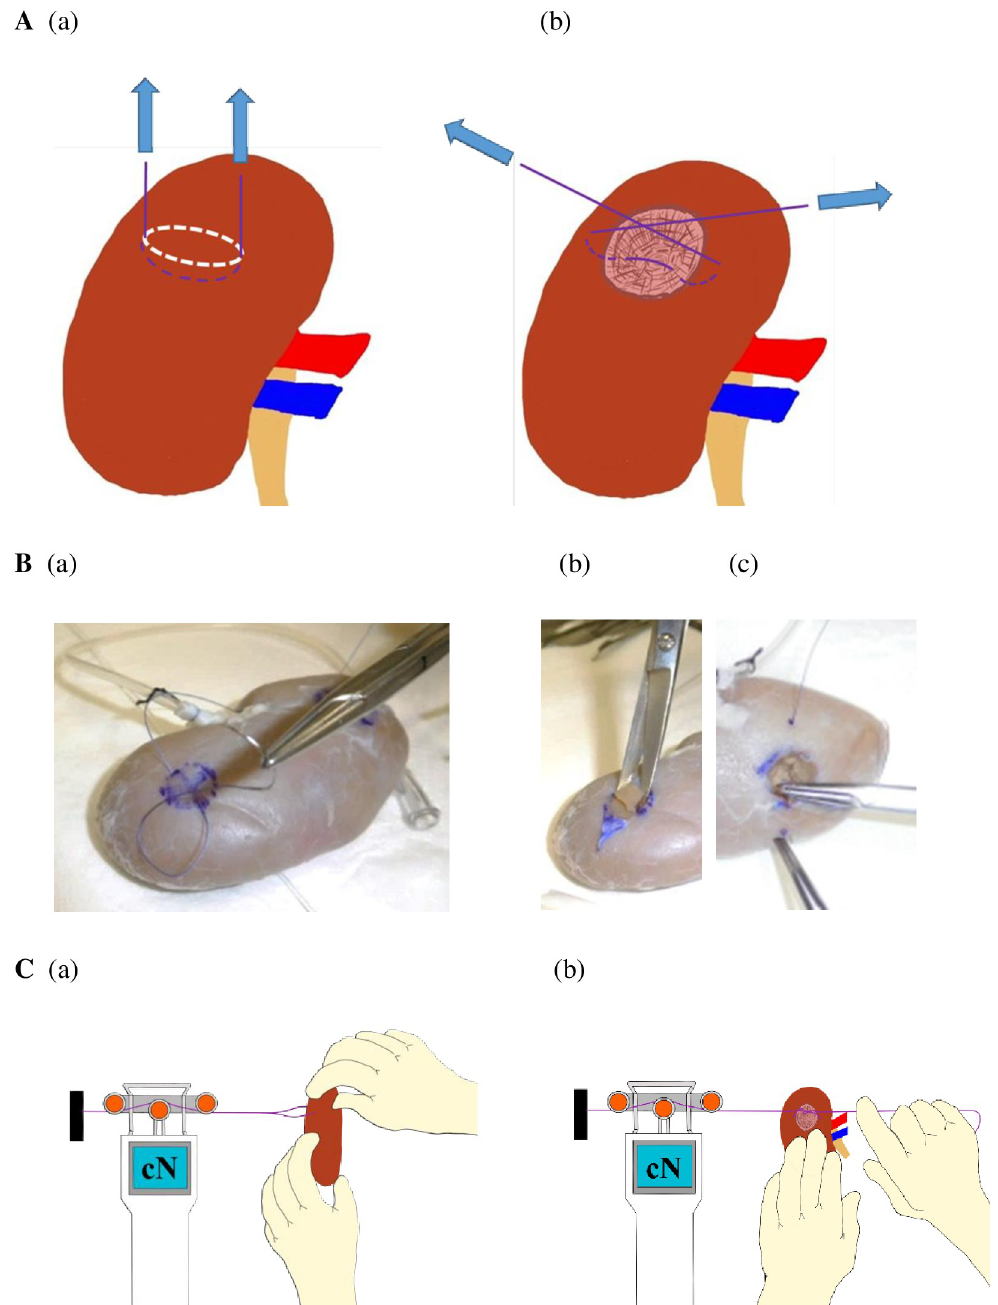
Fig 3. Strength evaluation. (A) Schematics to evaluate the strength of each kidney sample during towing (a) and during ligation (b). (B) The procedure of suturing. The drawing of a circle and the moving of the needle according to its diameter (a) resecting the renal parenchyma in a hemispherical shape (b) and moving the needle to close the defect of the renal parenchyma (c). (C) The procedure of towing (a) and ligation (b). See S1